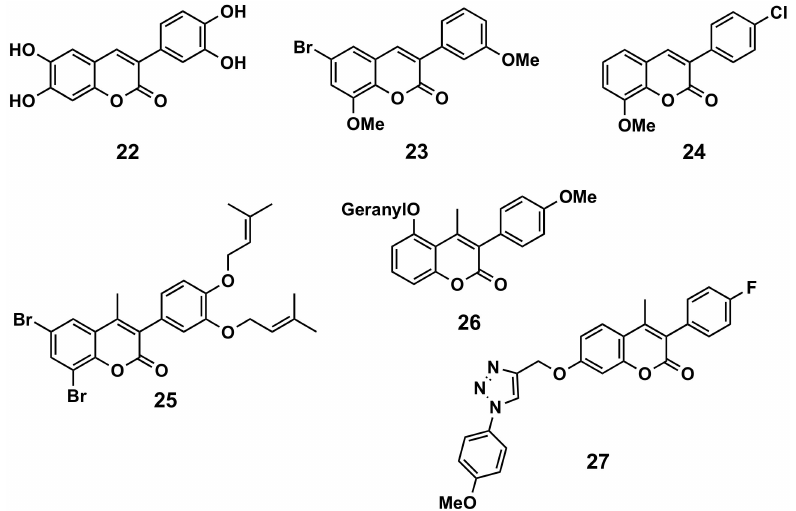
Figure 13. 3-Phenylcoumarins in inflammation.